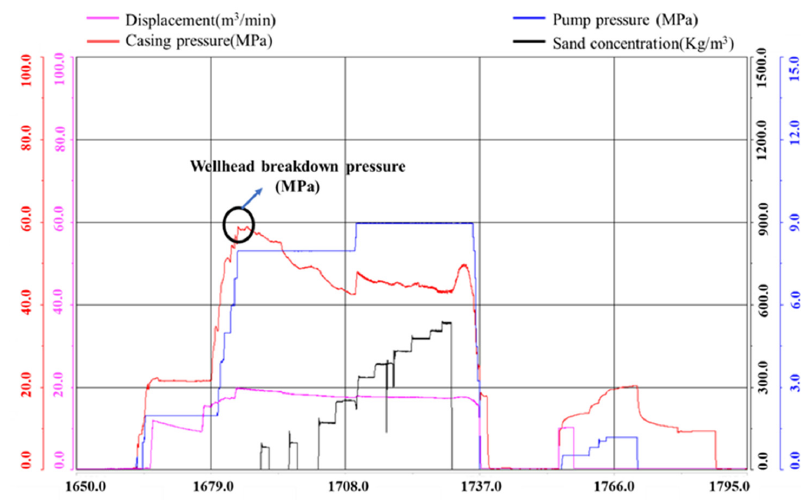
Figure 4. Fracturing construction curve of the first section of Well A.